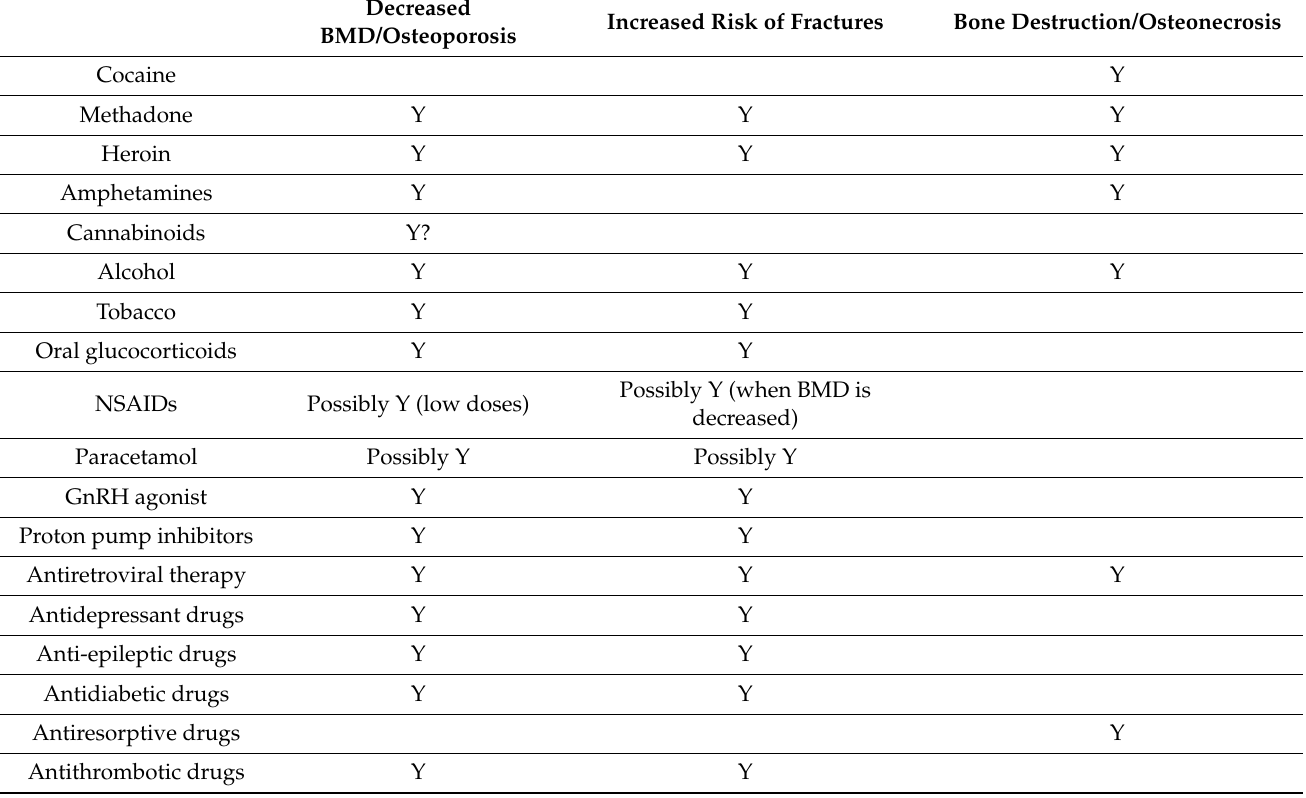
Table 2. Summary of effects on bones according to the drug class discussed in this paper. The absence of any information in the cells does not necessarily mean that these changes do not occur in a particular drug, but it has not been noted in the literature consulted for this paper. Code: Y = yes.